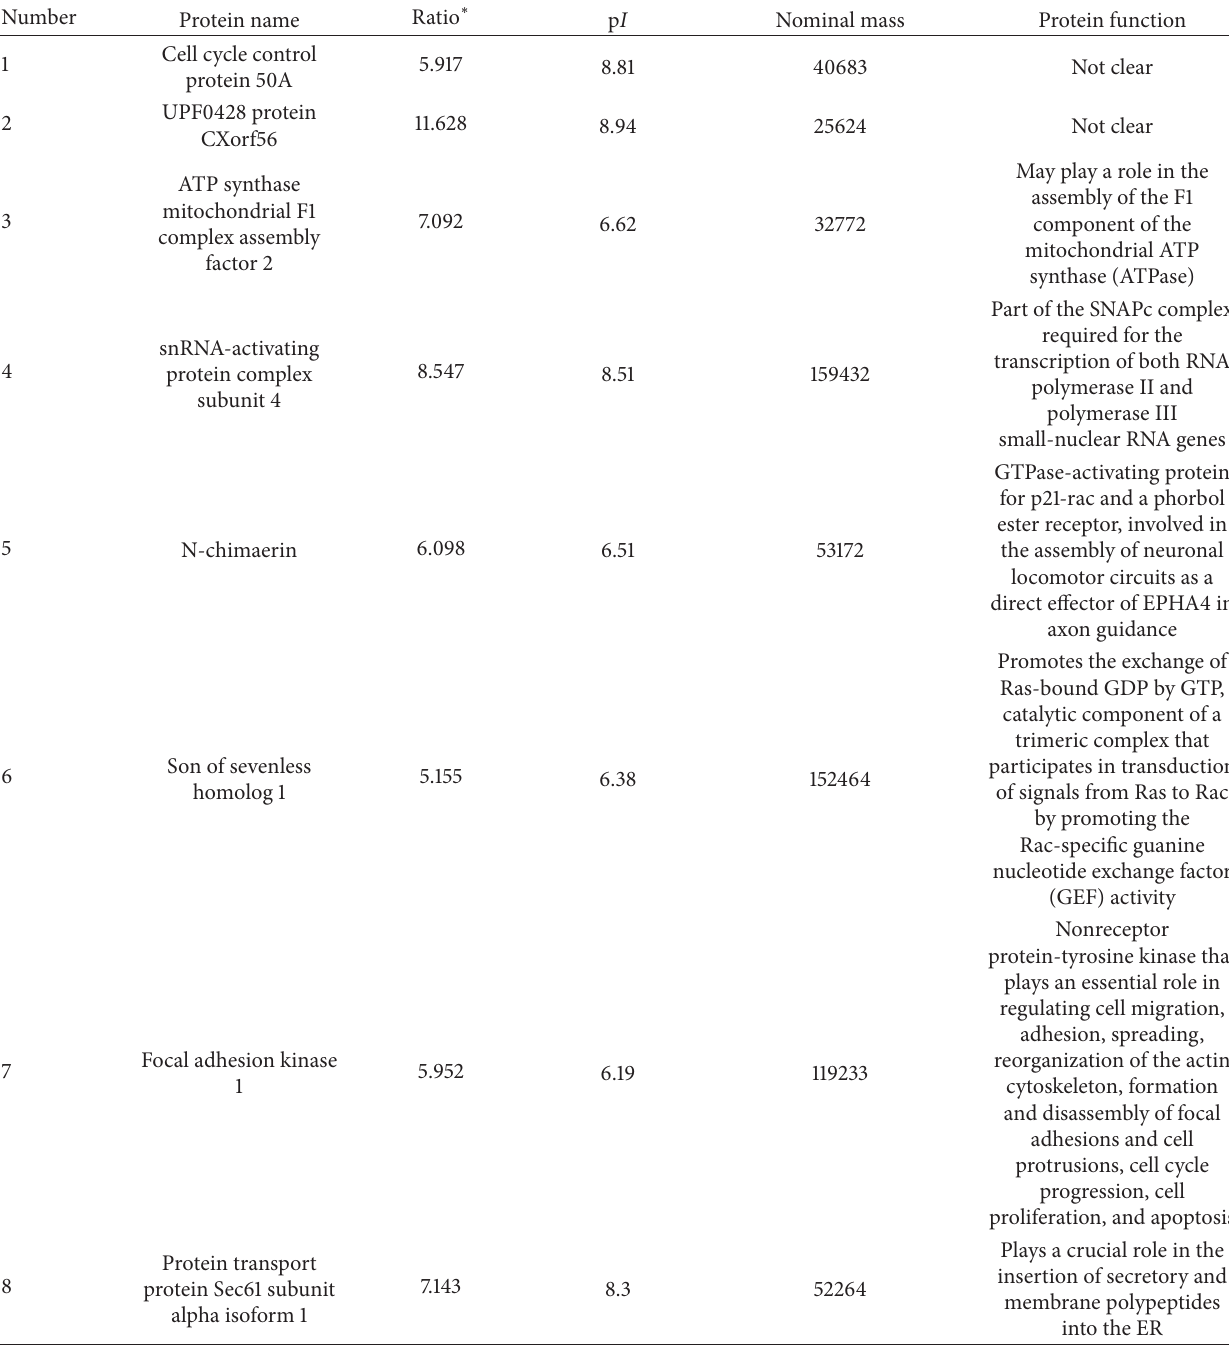
Table 2: Upregulated proteins in GES-1 cells treated with deoxycholic acid (ratio >